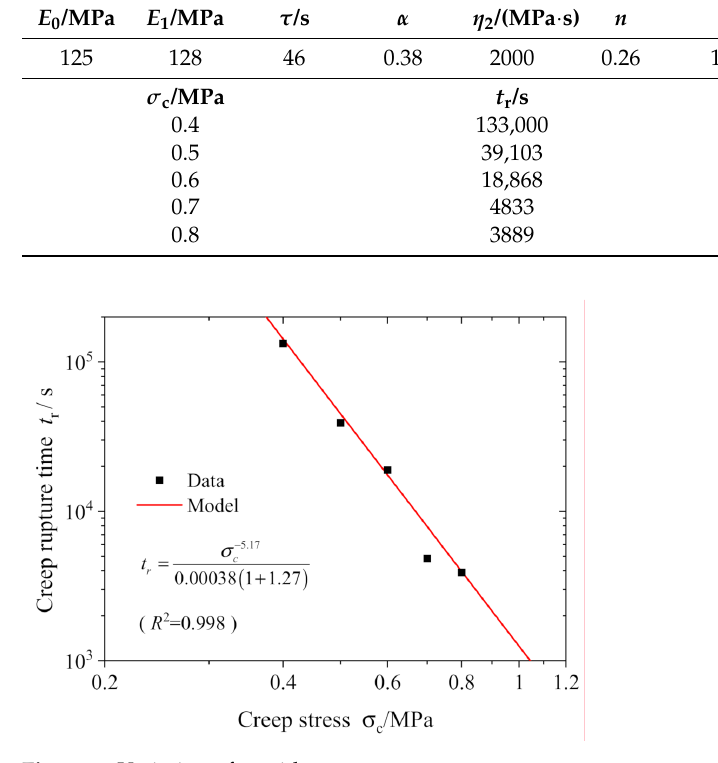
Figure 7. Variation of t r with creep